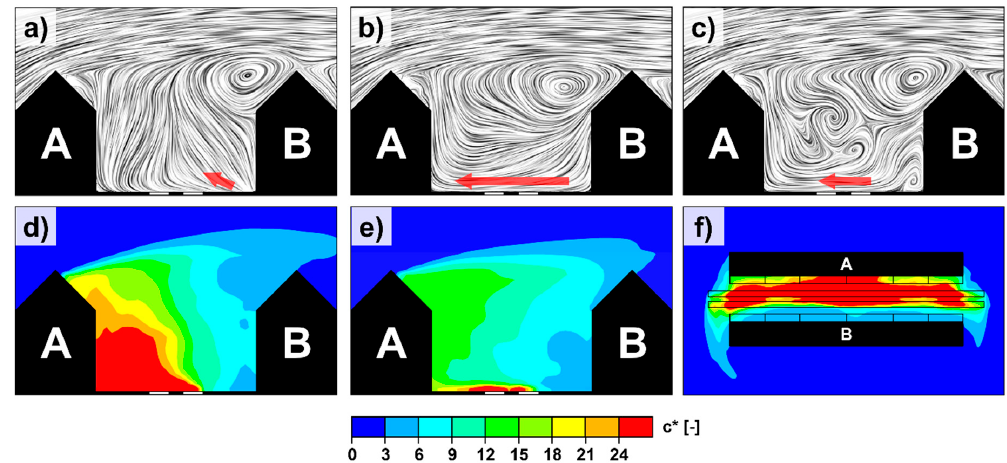
Figure 15. Typical flow structures of the street canyon completed with pitched roofs that have a 45° slope angle: ( a ) in the center area, at y /H = 0; ( b ) in the transitional area, at y /H = 2.5. ( c ) with a complex vortex structure in the center area. Typical normalized concentration contour plots: ( d ) in the center area, at y /H = 0; ( e ) in the transitional area, at y /H = 2.5 ( e ); ( f ) the typical distribution of air pollutants at ground level.